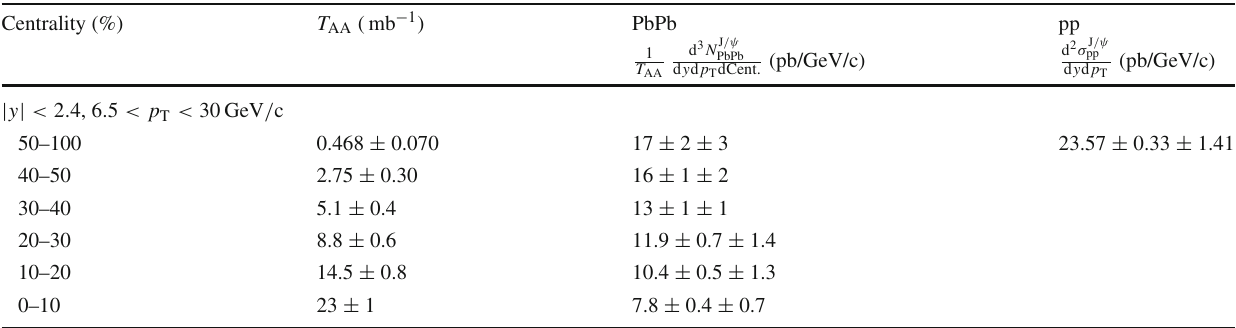
Table 5 The nonprompt J /ψ fiducial cross section in bins of central- ity, measured in PbPb and pp collisions at 2.76TeV within the muon acceptance defined by Eq. (4), and the nuclear overlap function ( T AA , with its systematic uncertainty). Listed uncertainties are statistical first